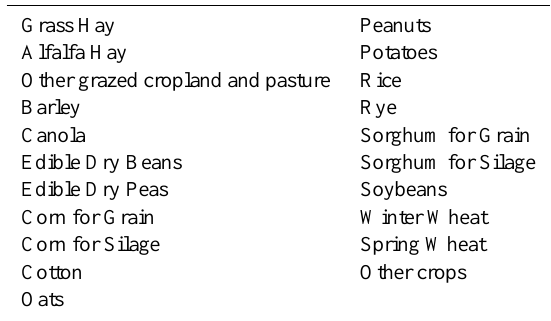
Table 2. Crops modeled within the Agricultural Fertilizer Modeling System